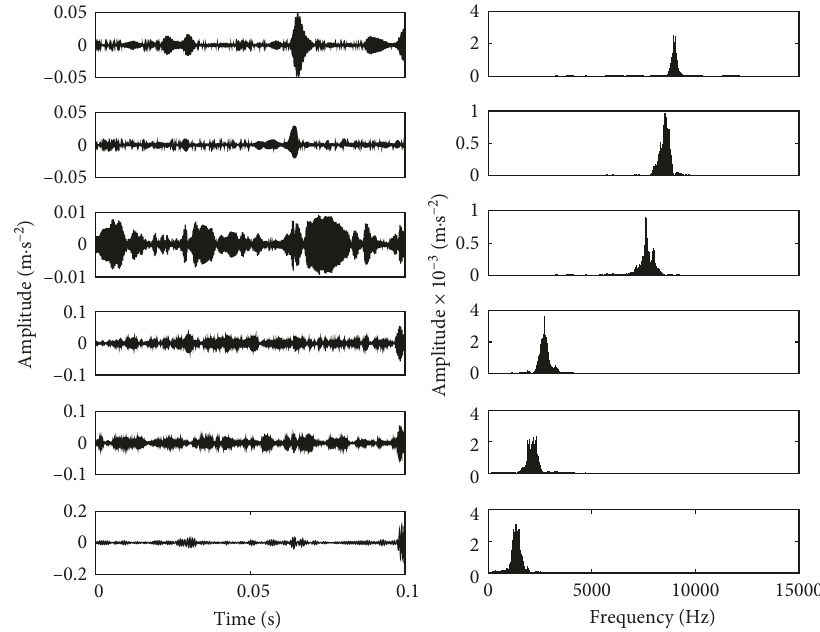
Figure 24: Waveform and spectrum of IMFs by VMD for rolling. Table 4: The kurtosis values and mutual information (MI) of IMFs for real signal with fluctuated